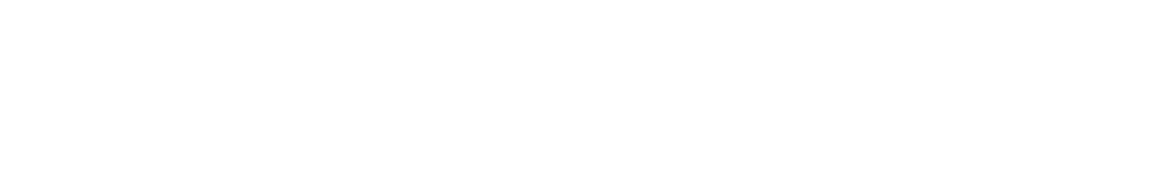
Frontiers in Earth Science |